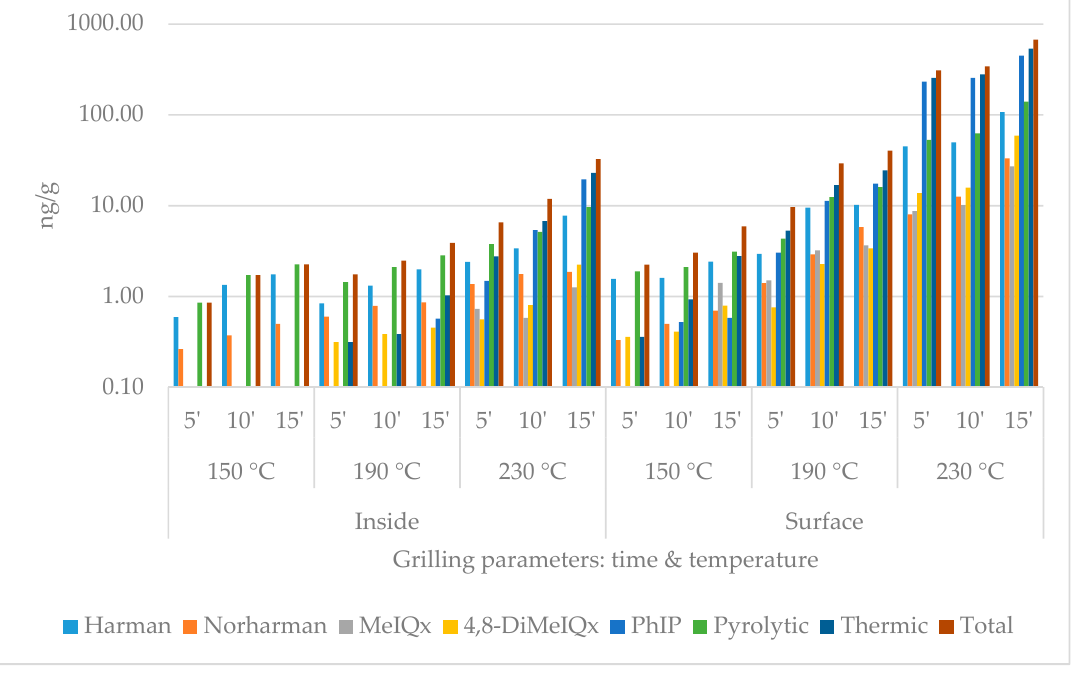
Figure 2 . Heterocyclic amine content of chicken breast with skin grilled with closed top plate. (logarithmic scale).